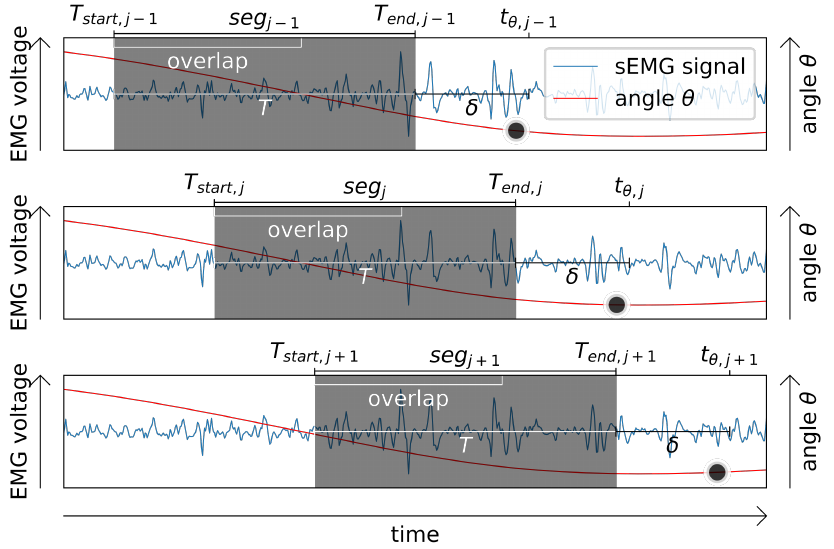
Figure 3. Exemplary representation of segment length T , offset δ and overlap for three successive segmentation time steps j . Each of the three subplots represent the same sEMG signal (blue) and corresponding elbow-joint angle θ (red) in each row. The gray boxes symbolically represent a segment of the sEMG signal from which features were extracted in each segmentation time step j . Depending on the feature extracted, segments of length T were reduced in dimensionality and mapped to a corresponding predicted angle ˆ θ (black dot) via the offset δ . The overlap of segments between successive segmentation time steps j and j + 1 determines the frequency by which features were